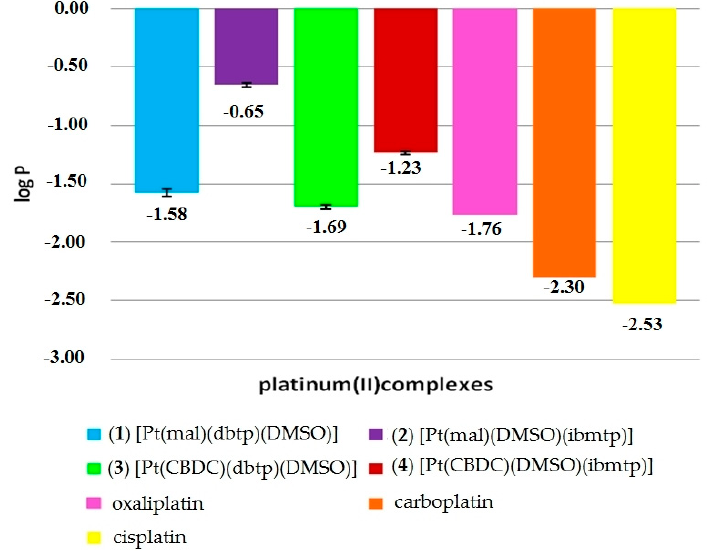
Figure 4. Lipophilicity of platinum(II) complexes.